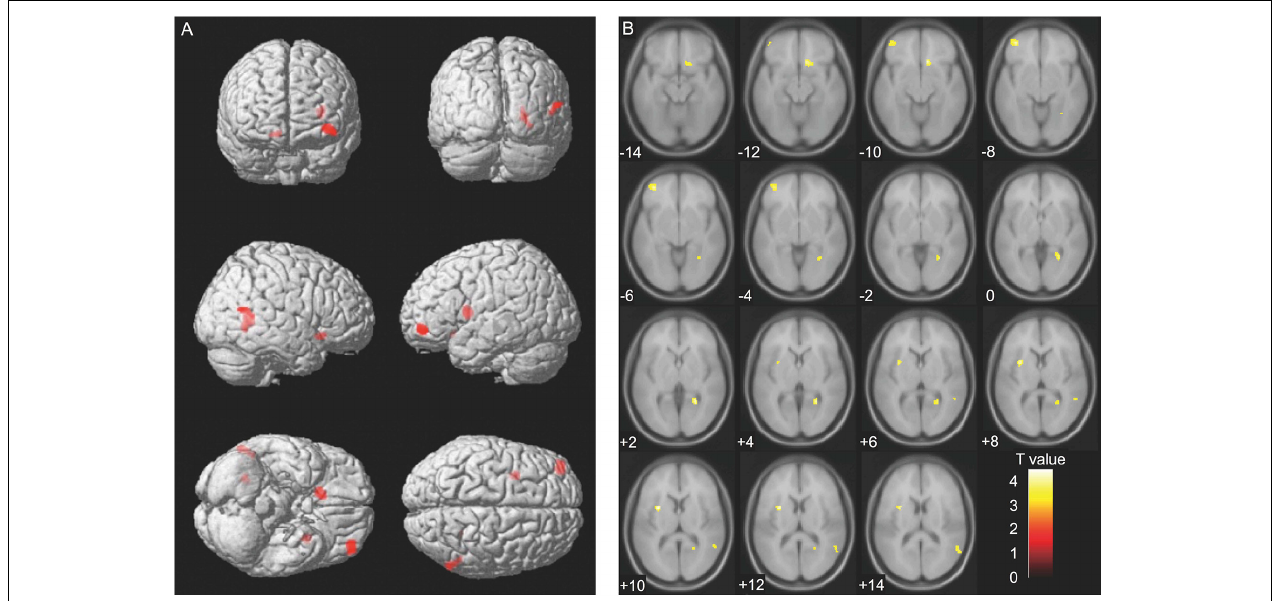
FIGURE 2 | Voxel-based morphometry findings: Association between serum sTREM2 levels (Time 1) and brain volume (Time 2). Positive correlation between serum sTREM2 levels (Time 1) and brain volume (Time 2), as shown by multiple regression analysis. The threshold for statistics were set to T = 3.23 for the height threshold and k = 122 voxels for the extent threshold. Volumes of the important regions are shown in (A) whole brain images and (B) axial images. The T -value applies to (B) axial images. TABLE 4 | Voxel-based morphometry (VBM) findings.